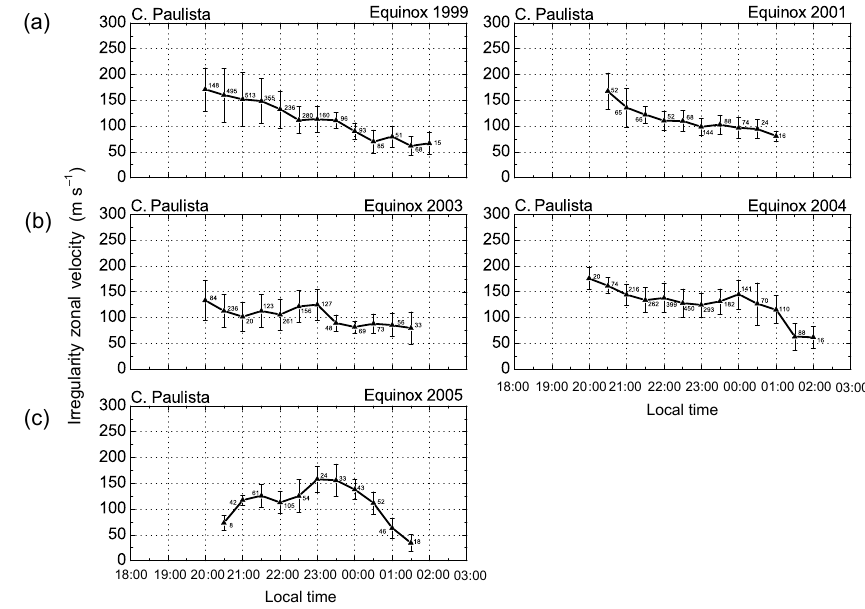
Figure 3. Nocturnal variations in the irregularity zonal (eastward) drift velocities estimated at Cachoeira Paulista during the equinoctial periods of the years 1999 and 2001 (a) , 2003 and 2004 (b) , and 2005 (c) .